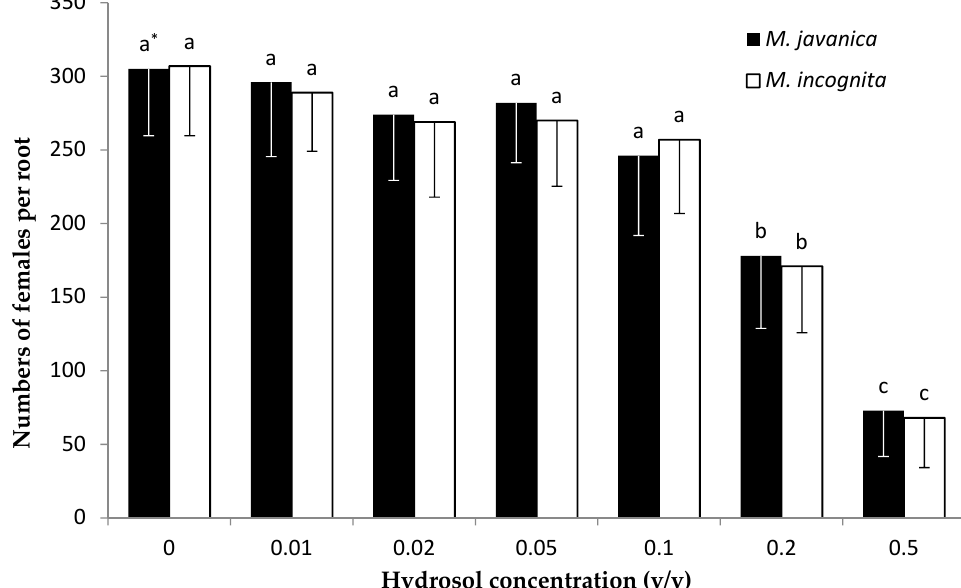
Figure 8. Number of females of Meloidogyne javanica and M. incognita per tomato root system in soil treated with Cuminum cyminum seed hydrosol at concentrations of 0, 0.01, 0.02, 0.05, 0.1, 0.2, and 0.5 v/v and inoculating with 600 J2s. * Bars with the same color followed by the same letter are not significantly different according to Tukey’s HSD test at p <